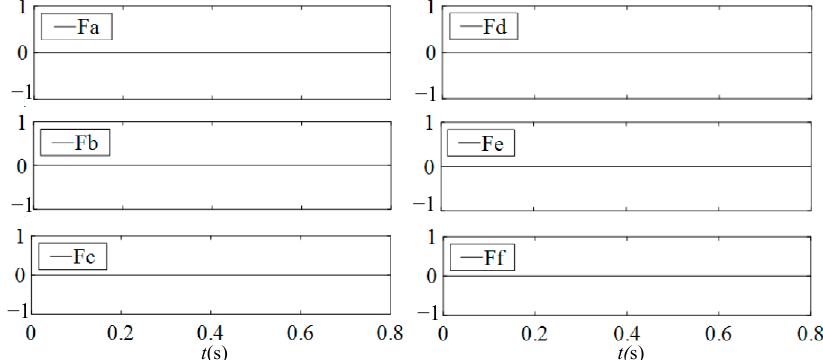
Figure 9. Current waveform of load and disturbance during normal operation.